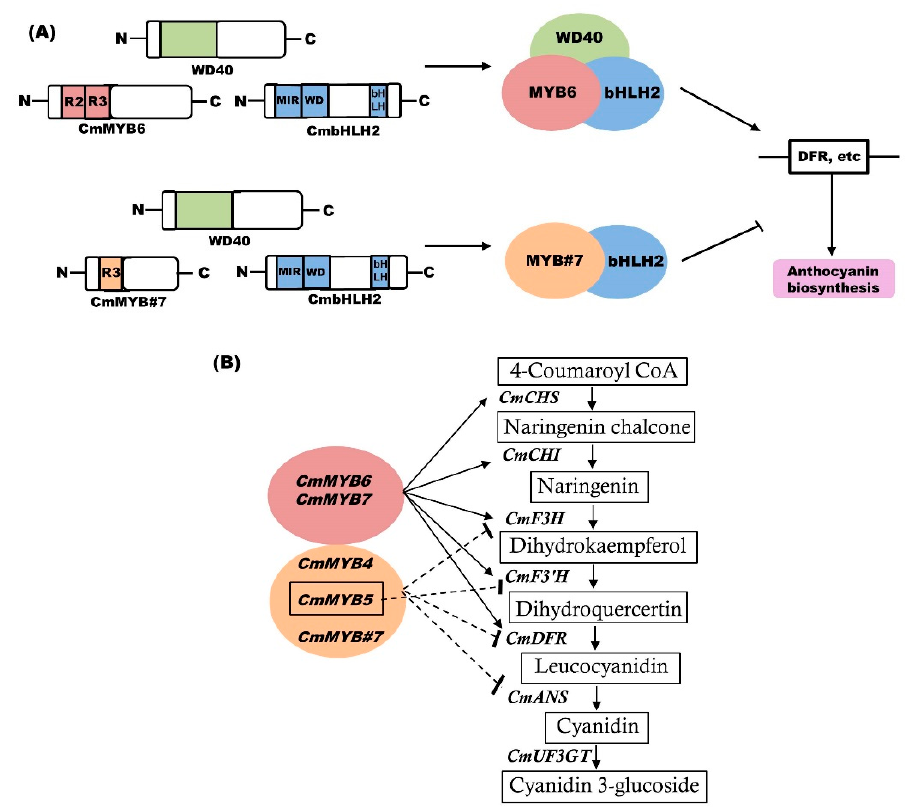
Figure 2. MYB-bHLH-WD40 (MBW) complex for the regulation of anthocyanin biosynthesis. ( A ) Schematic model to depict the regulatory mechanism of the MBW complex. bHLH proteins interacts with MYB transcription factors (TFs) and WD40 to form a ternary complex, thereby regulating structural genes. (i) Activation of anthocyanin biosynthesis regulation by MYB-activators. (ii) Repression of anthocyanin biosynthesis by MYB-repressors, which compete with MYB-activators for bHLH. Arrows (‘ → ’) indicate activation, and blocked lines (‘—|’) indicate repression. ( B ) Representative MYBs for the regulation of anthocyanin biosynthesis. CmMYB6 and CmMYB7 are positive regulators of anthocyanin biosynthesis. In contrast, CmMYB4 , CmMYB5, and CmMYB#7 are repressors of anthocyanin biosynthesis. The arrow indicates activation and the dotted blocked arrow indicates repression (modified from [66].